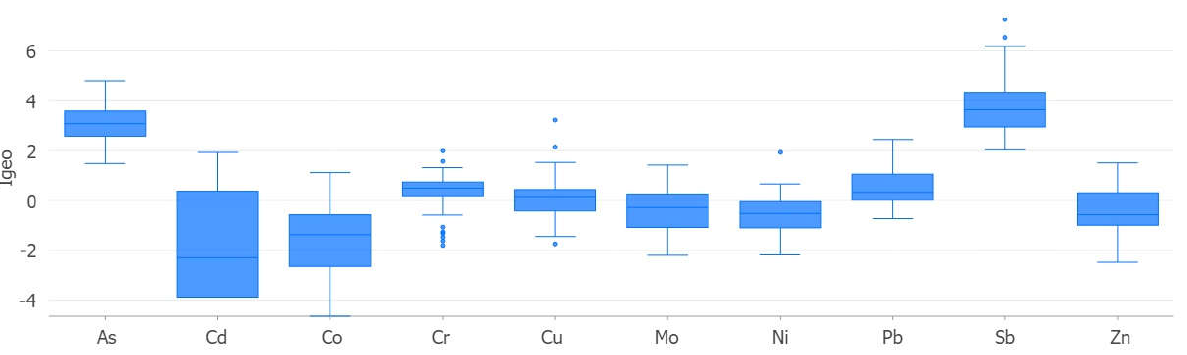
Figure 3. Igeo determined based on average crustal concentrations of metals and metalloids.